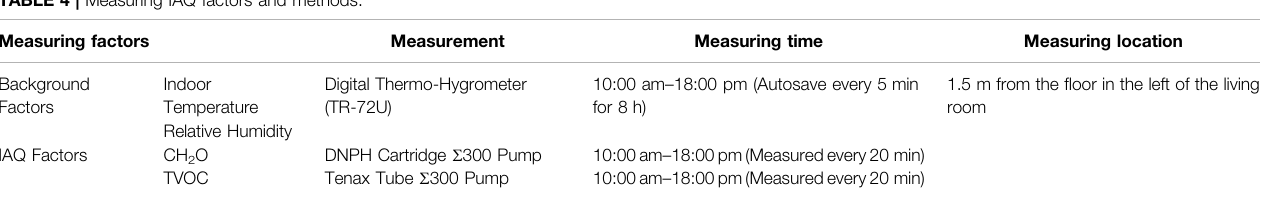
TABLE 4 | Measuring IAQ factors and methods.